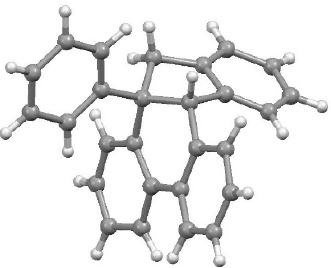
Figure 9. Molecular structure of 43 , the double benzyne adduct to 2-phenylindene.